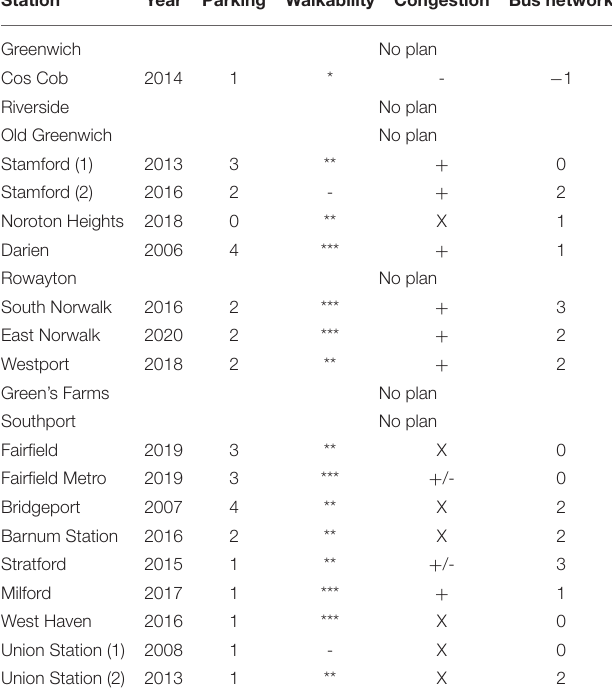
TABLE 2 | Station plan